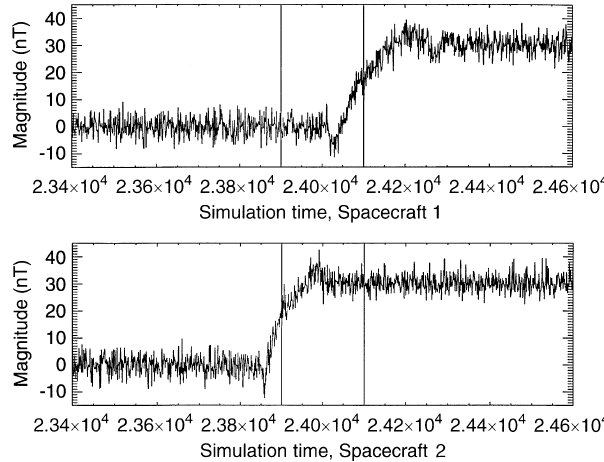
Fig. 7. The low pass filtered, time stationary datasets. The filter cut o(cid:128) frequencies above the threshold of 100 D f . The abscissa denotes the sampling time step ~ t and the ordinate the smoothed B ? field magnitude